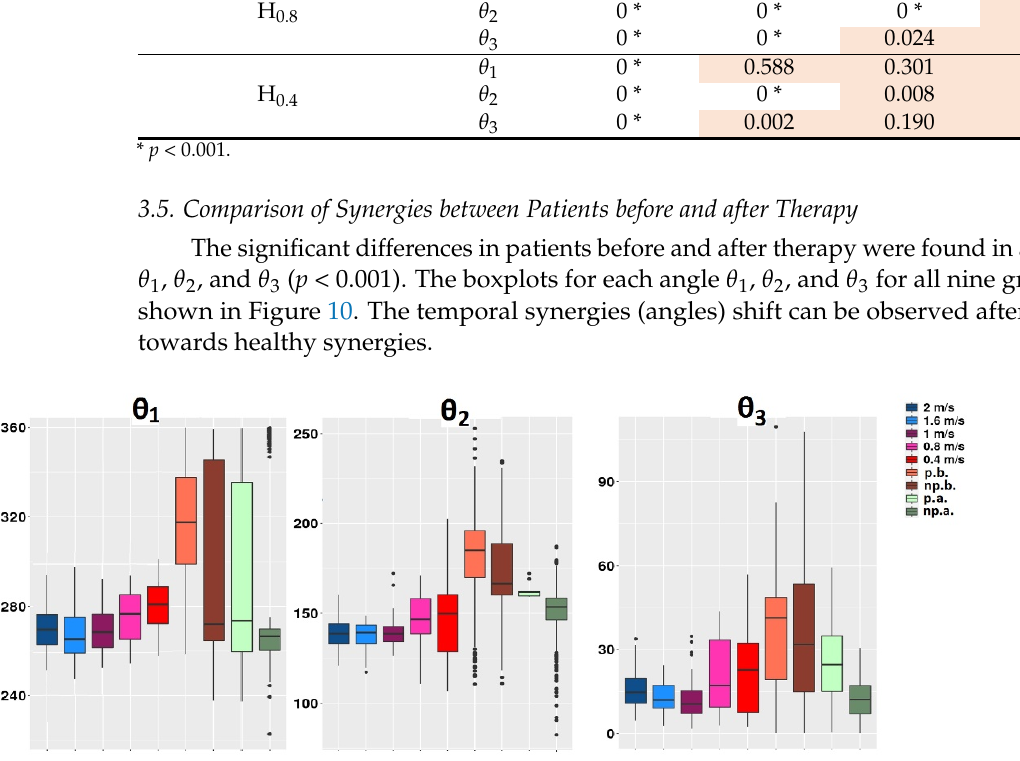
Figure 10. Temporal synergies (angles θ 1 , θ 2 , and θ 3 ) for all groups.